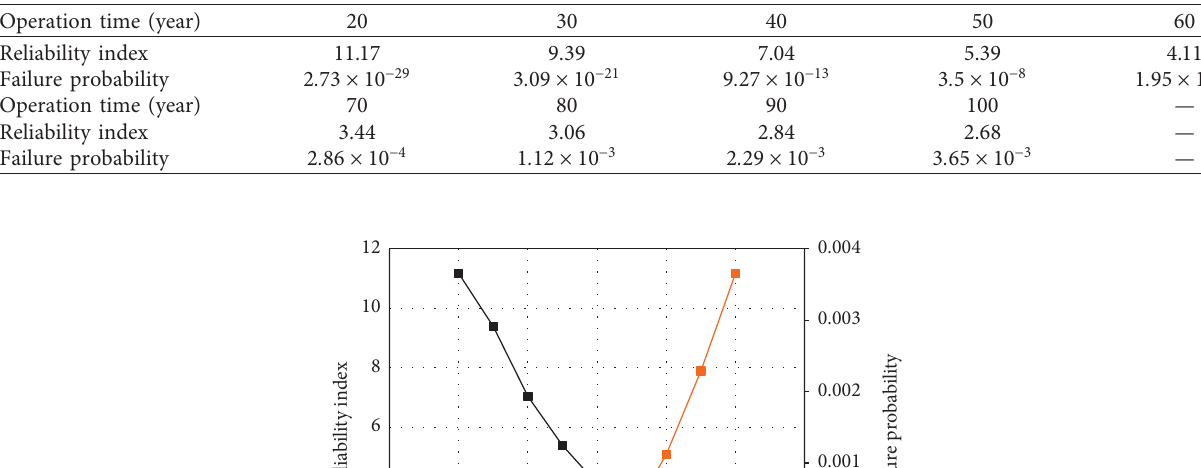
Table 6: Reliability index and failure probability with different operation times.